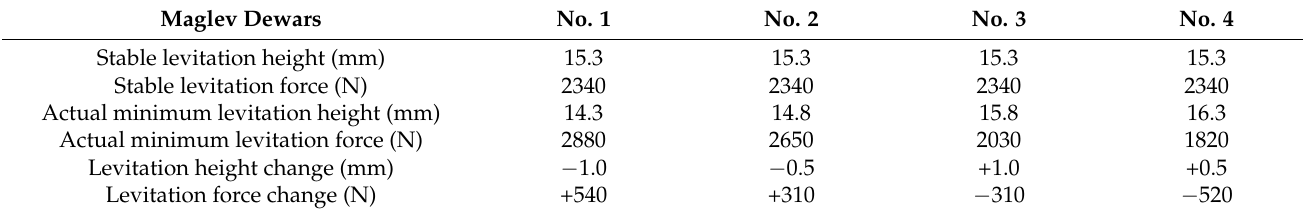
Table 5. Variation in the levitation heights and levitation forces of Dewar under V 0 = 60 km/h and 10 mm air